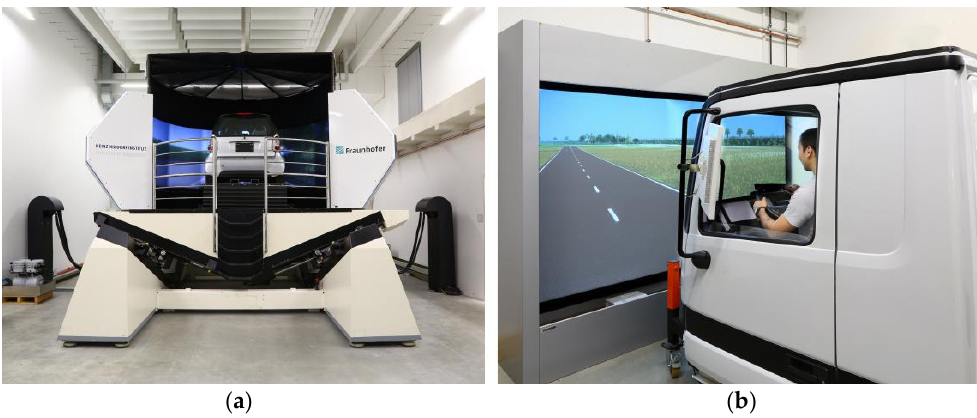
Figure 1. Two driving simulator variants at the Heinz Nixdorf Institute in Germany: ( a ) Passenger car driving simulator with a motion platform; ( b ) Stationary truck driving simulator.